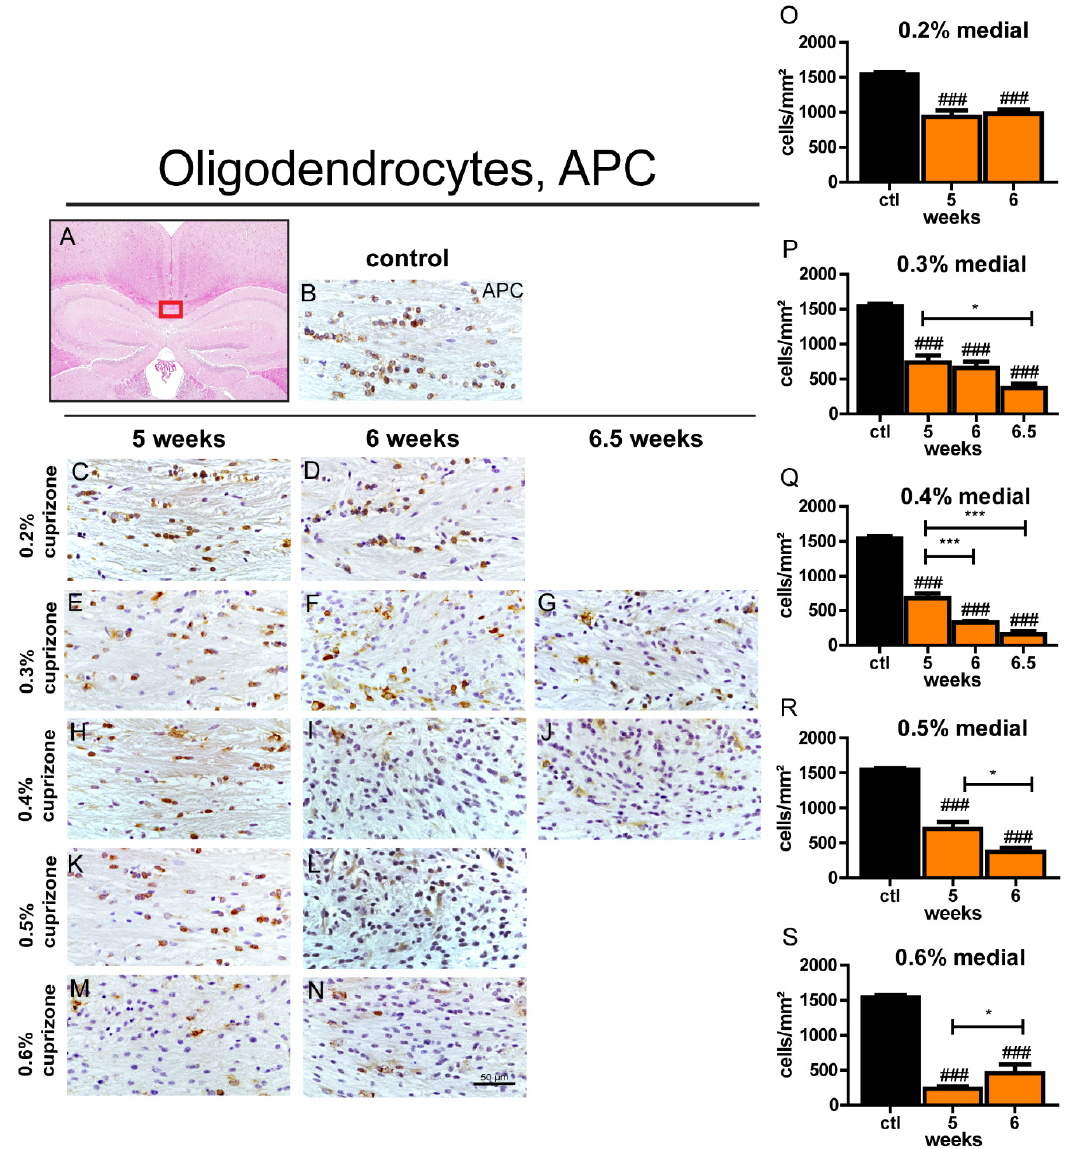
Figure 2. Depletion of adult oligodendrocytes in the midline of the corpus callosum in aged mice